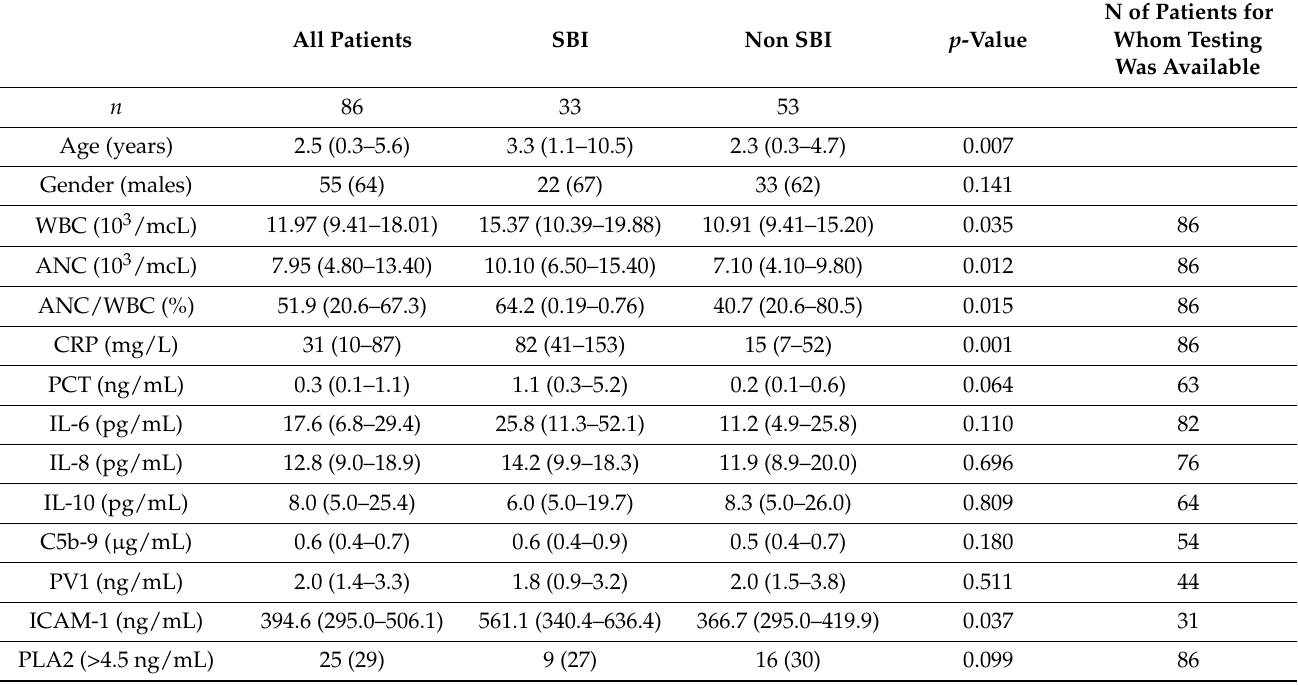
Table 5. Biomarker levels in non-immunocompromised patients.